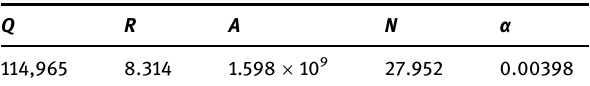
Table 4: Fitted material constants